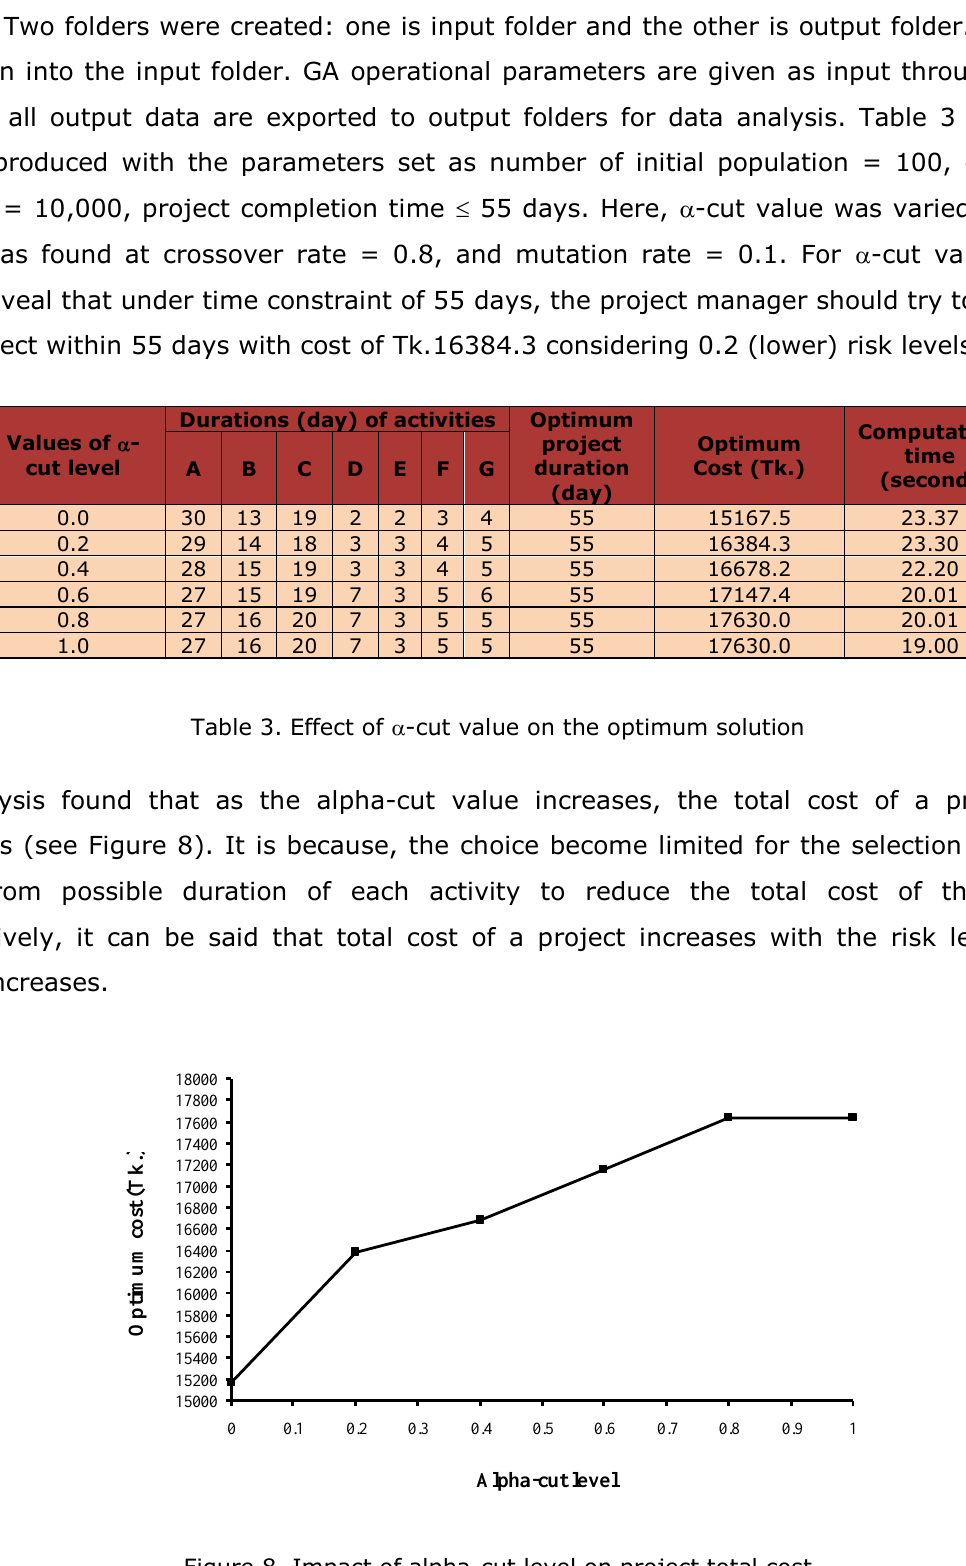
Figure 8. Impact of alpha-cut level on project total